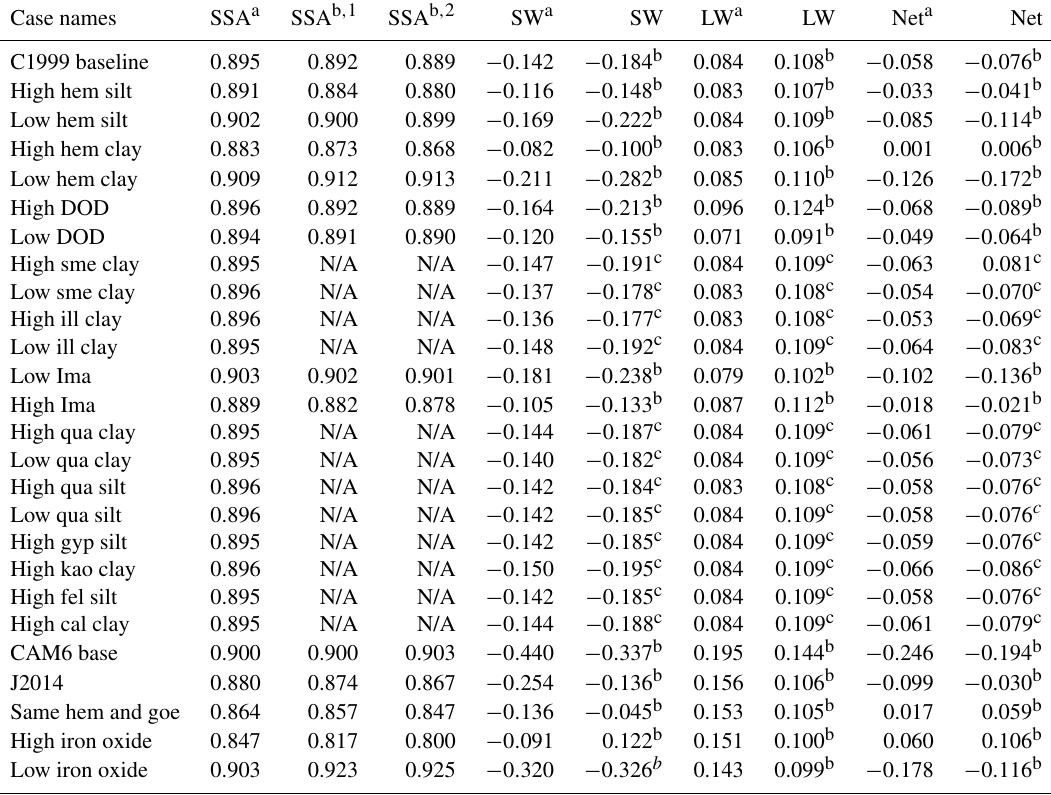
Table 5. Global mean SSA at the 0.44–0.63µm band and DRE in shortwave (SW) and longwave (LW) spectra and their sum (Net) for different cases in CAM5 and CAM6. DOD for all cases is approximately 0.03 except “High DOD” ( ∼ 0 . 035) and “Low DOD” ( ∼ 0 . 025). Values in the last four rows are obtained in CAM5 using J2014 with different and identical optical properties for hematite and goethite (same hem and goe). See descriptions for the case name in Table